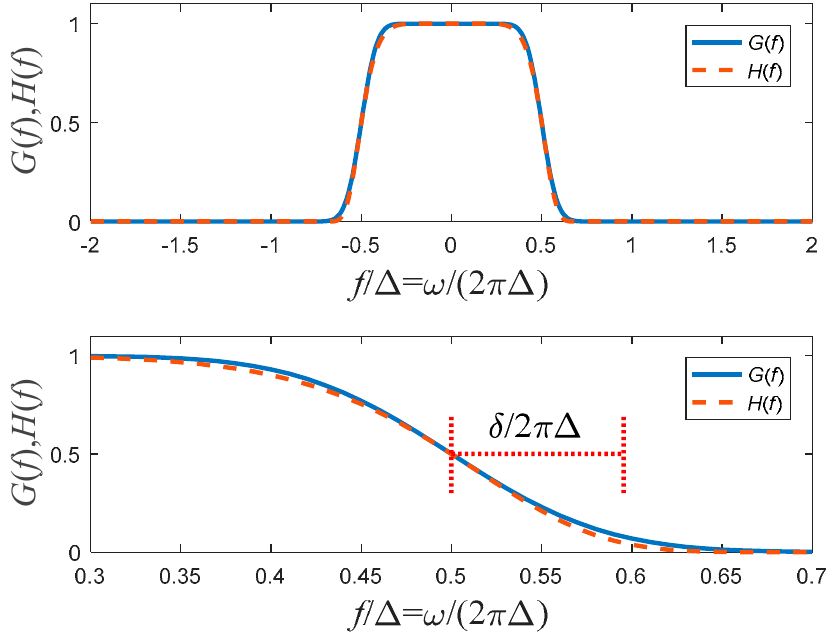
Figure 8. Comparison between smooth rectangular (SR) filter (solid curve) and its equivalent super Gaussian (SG) filter (dashed curve).